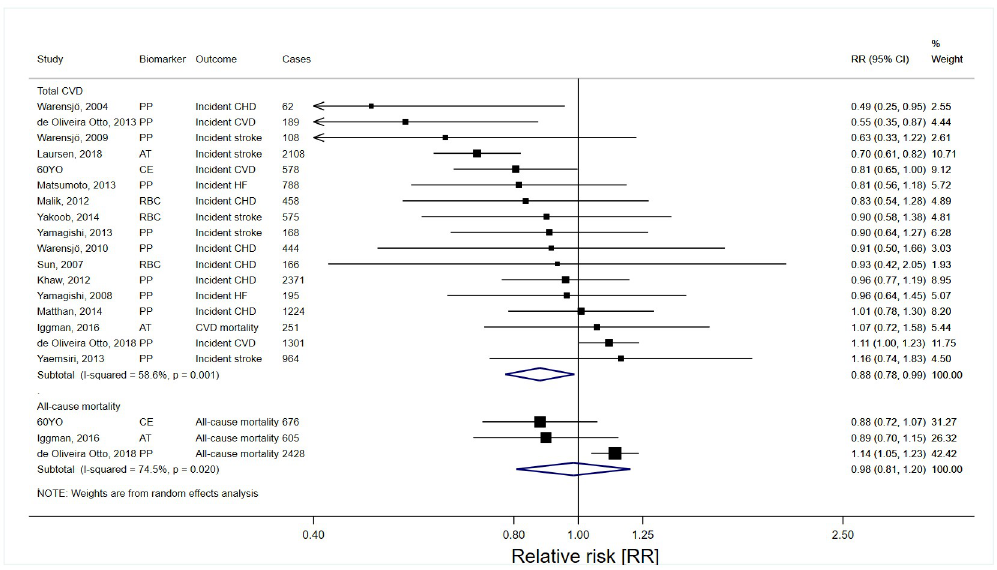
Fig 4. Risk estimates for CVD incidence and all-cause mortality in the top tertile of pentadecanoic acid (15:0) relative to the bottom tertile. AT, adipose tissue; CE, cholesterol ester; CHD, coronary heart disease; CI, confidence interval; CVD, cardiovascular disease; HF, heart failure; PP, plasma phospholipids; RBC, red blood cell (erythrocyte); RR, relative risk.